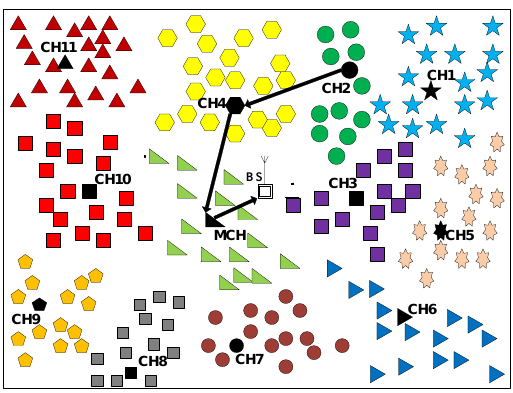
Figure 1. Optimal route-finding in the PECR algorithm.